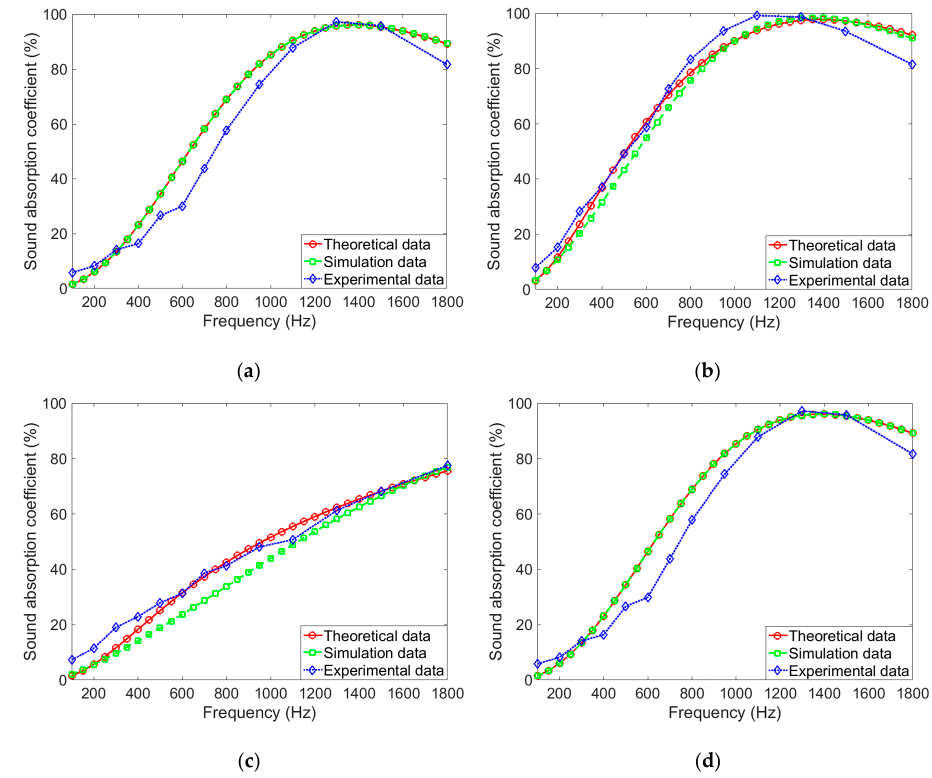
Figure 6. Comparisons of theoretical data, simulation data, and experimental data with the limited total thickness of 30 mm. ( a ) Porous metal + cavity + microperforated panel + cavity; ( b ) Microperforated panel + cavity + porous metal + cavity; ( c ) Porous metal + cavity; ( d ) Microperforated panel + cavity.